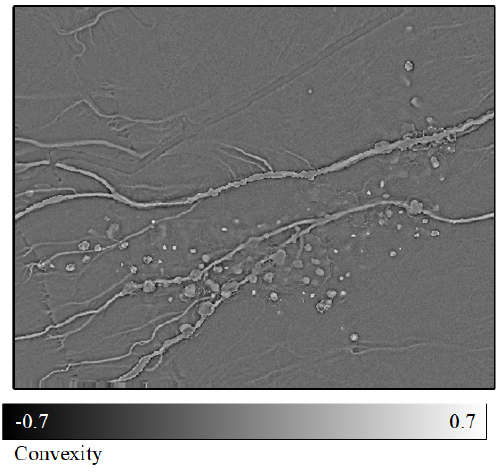
Figure 6. Convexity estimation at the alluvial fan, using a neighborhood of radius 4 m, in accordance to the approximate mean size of the entities.